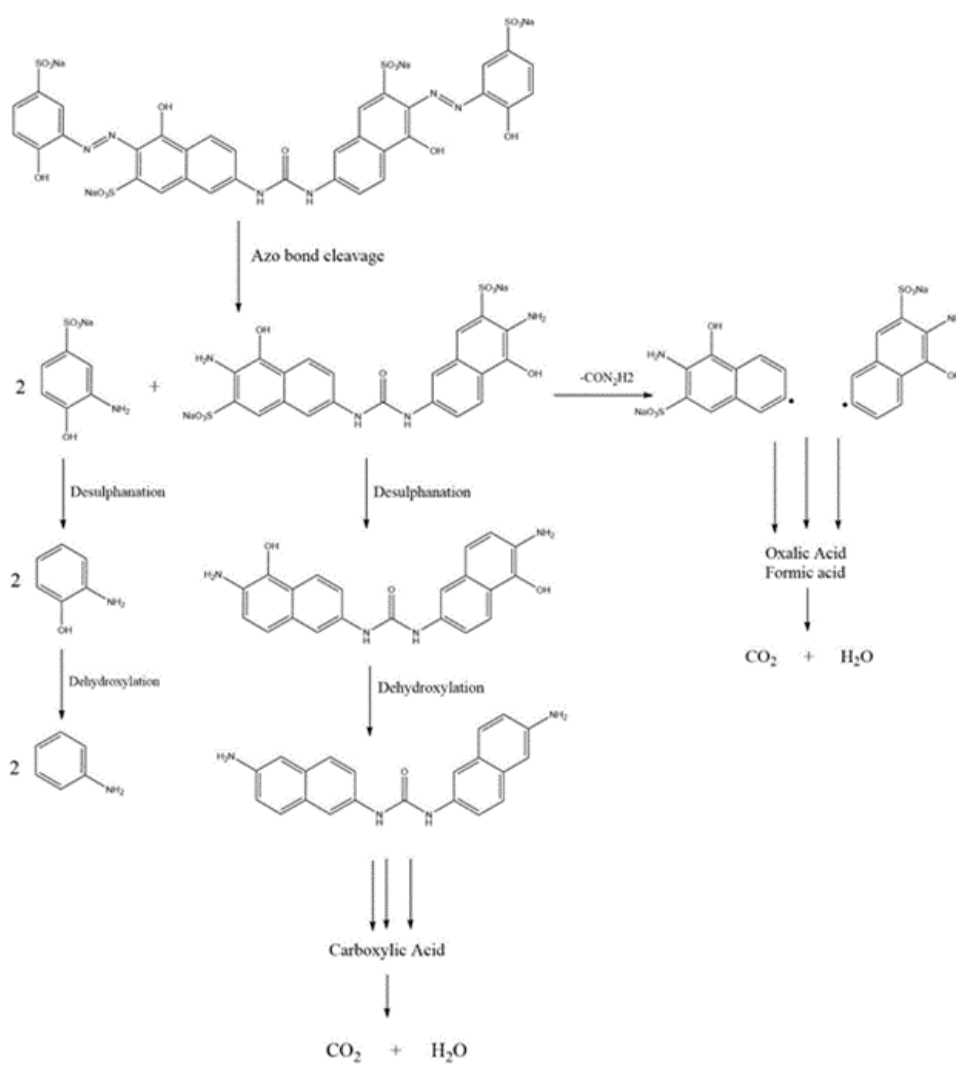
Figure 8. The expected mechanism for the degradation of Direct Red 83 dye.